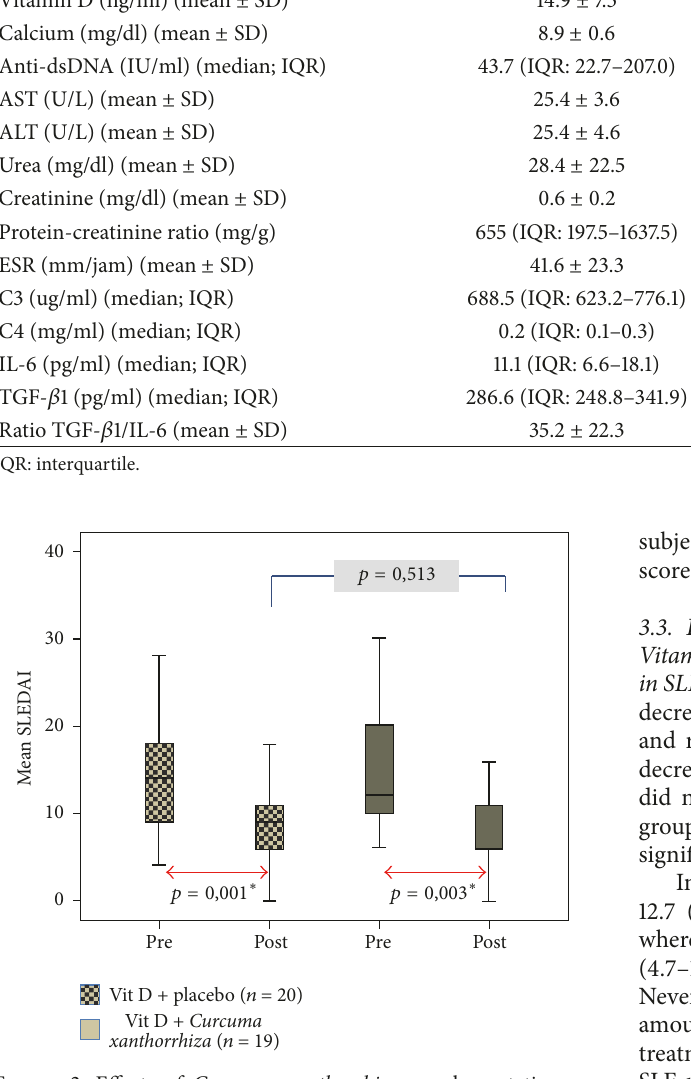
Figure 2: Effects of Curcuma xanthorrhiza supplementation on vitamin D 3 administration towards SLEDAI. ∗ There is a significant difference ( 𝑝 < 0.005